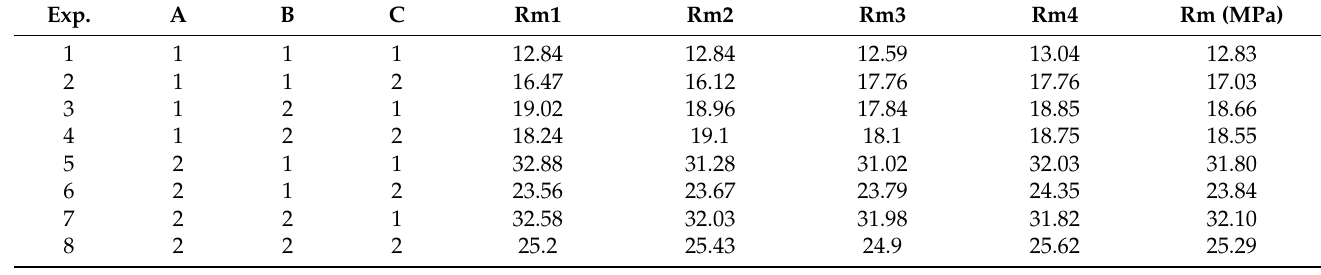
Table 5. Measured values of Tensile Strength.